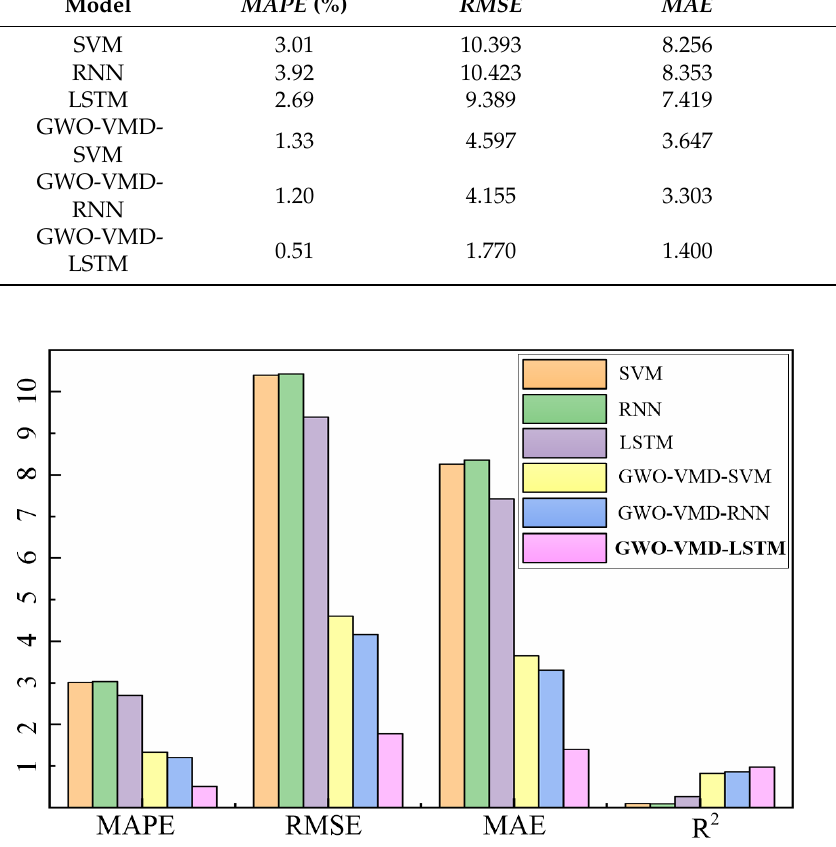
Figure 11. Comparison of prediction error between different models for selected data sets.